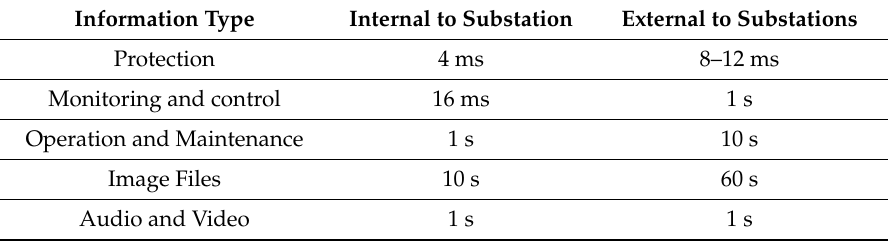
Table 2. Requirements for data delivery time based on IEEE 1646 Standard